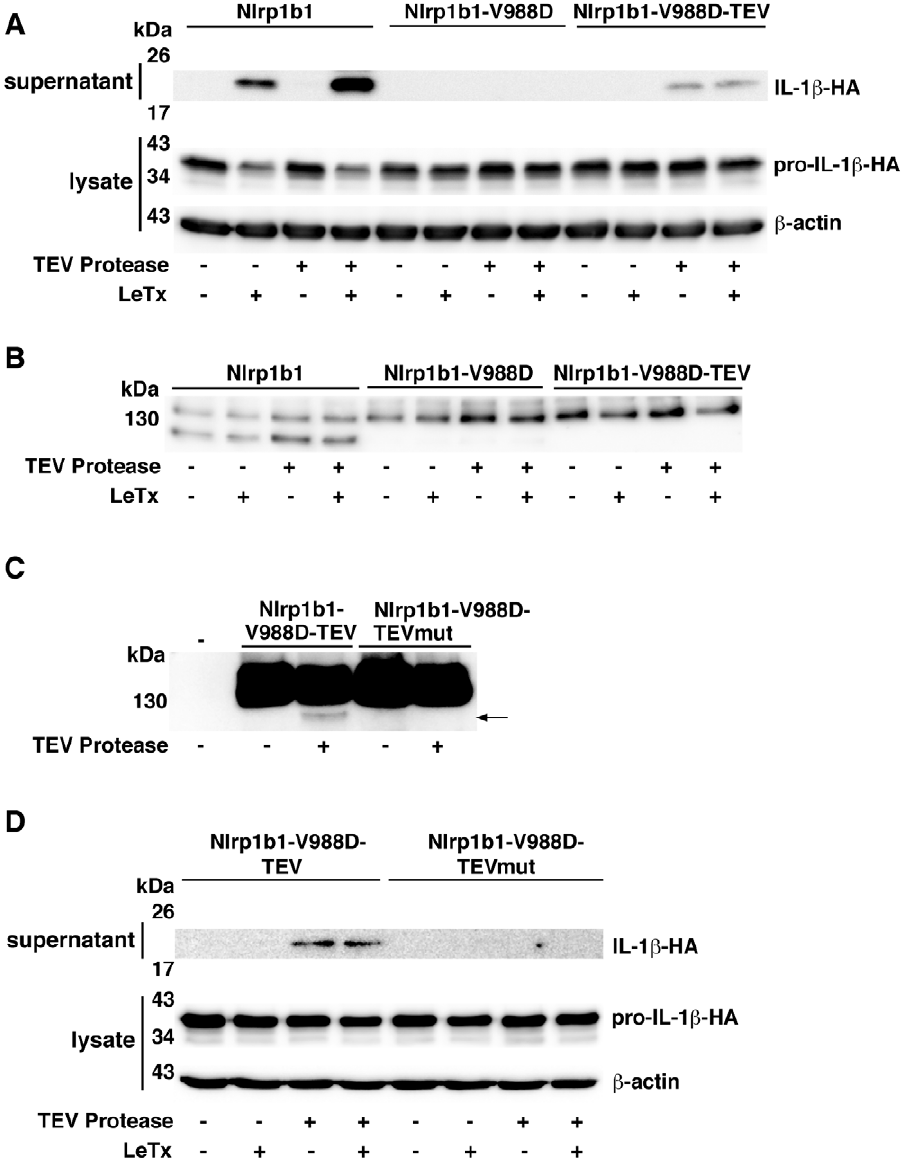
Figure 6. Restoration of cleavage in the Nlrp1b1 V988D mutant rescues inflammasome activity. (A and D) Cells were transfected with pcDNA3-pro-IL-1 b -HA and pcDNA3-pro-caspase-1-T7 in addition to the indicated combinations of pNTAP plasmids encoding Nlrp1b proteins and pcDNA3-TEV-protease-T7. Approximately 24 h after transfection, cells were treated with LeTx for 3 h. Cell lysates were collected and probed for HA- tagged pro-IL-1 b and b -actin; cell medium was collected and immunoprecipitated with anti-HA antibodies and probed for HA-tagged IL-1 b by immunoblotting. (B) HT1080 cells were transfected with pNTAP plasmids encoding Nlrp1b proteins, pcDNA3-pro-IL-1 b -HA, and pcDNA3-TEV- protease-T7 as indicated. Approximately 24 h after transfection, cells were treated with LeTx (10 2 8 M LF and 10 2 8 M PA) for 3 h. Cells were lysed and TAP-tagged proteins were precipitated with streptavidin resin and immunoblotted using an Nlrp1b antibody. (C) Cells were transfected with pNTAP plasmids encoding the indicated Nlrp1b proteins and pcDNA3-TEV-protease-T7 as indicated. Approximately 24 h following transfection, cells were lysed and TAP-tagged proteins were precipitated with streptavidin resin and immunoblotted using an Nlrp1b antibody. Arrow indicates cleavage product. Blots are representative of three independent experiments.